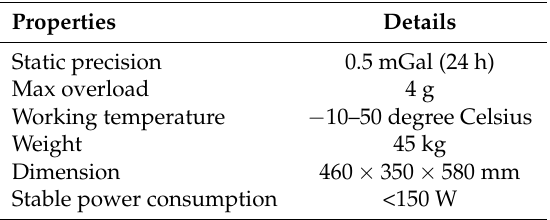
Table 2. Properties of